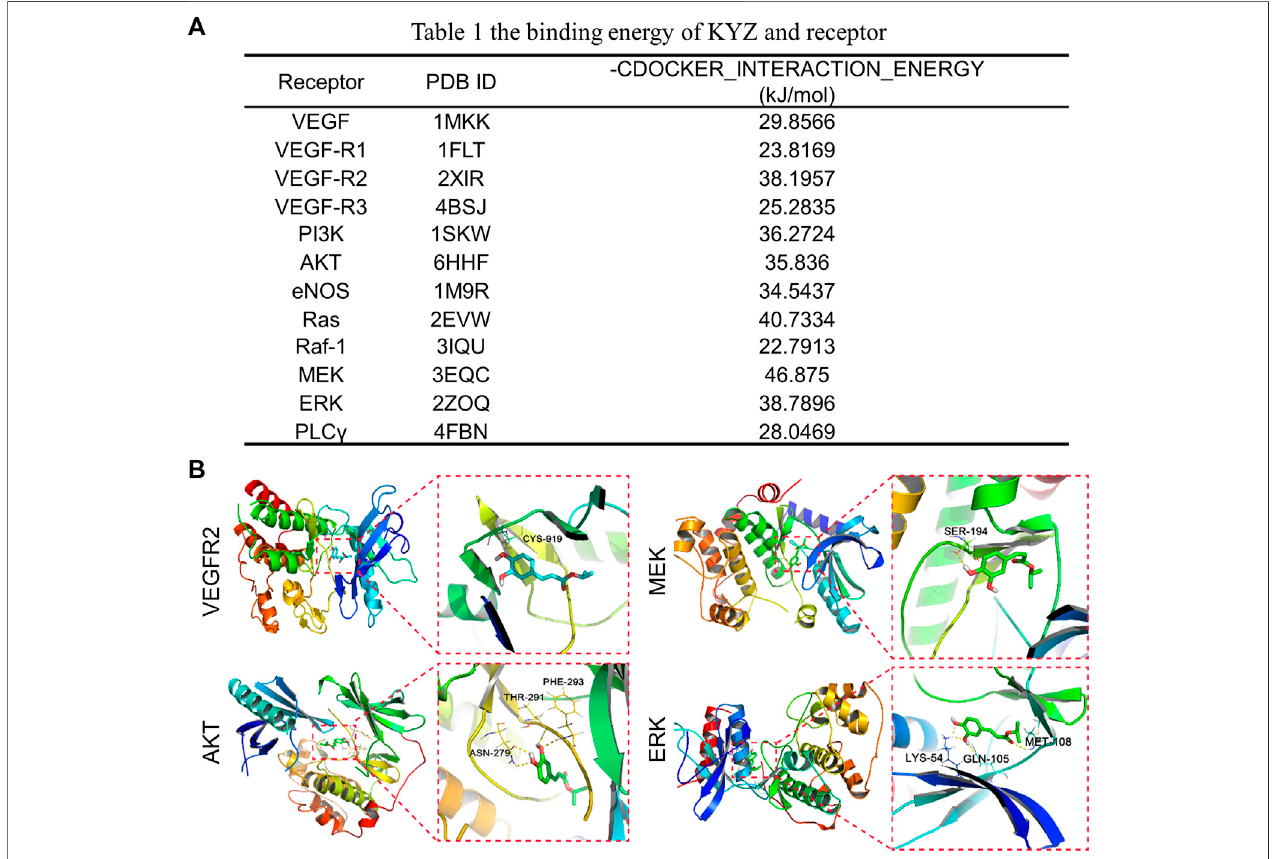
FIGURE2|(A) ThebindingenergyofKYZwiththepredictedproteinreceptors.Thelowerbindingenergyindicatesthehigheraf fi nityofKYZwiththetargetprotein. (B) Docking analysis of KYZ with proteins VEGFR2, AKT, MEK1/2, ERK1/2 visualized using Pymol software.